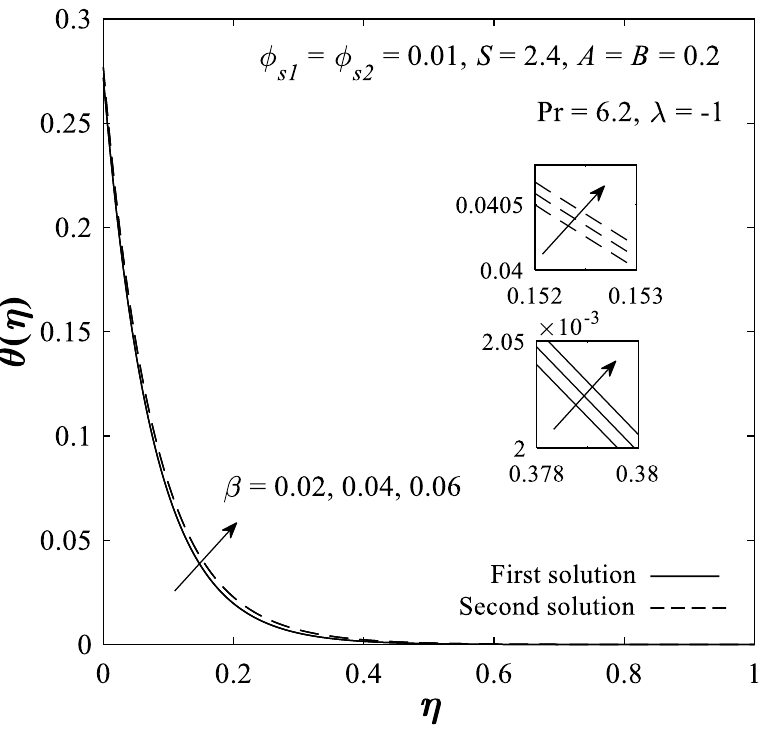
Figure 17. Temperature profile θ ( η ) for varied β